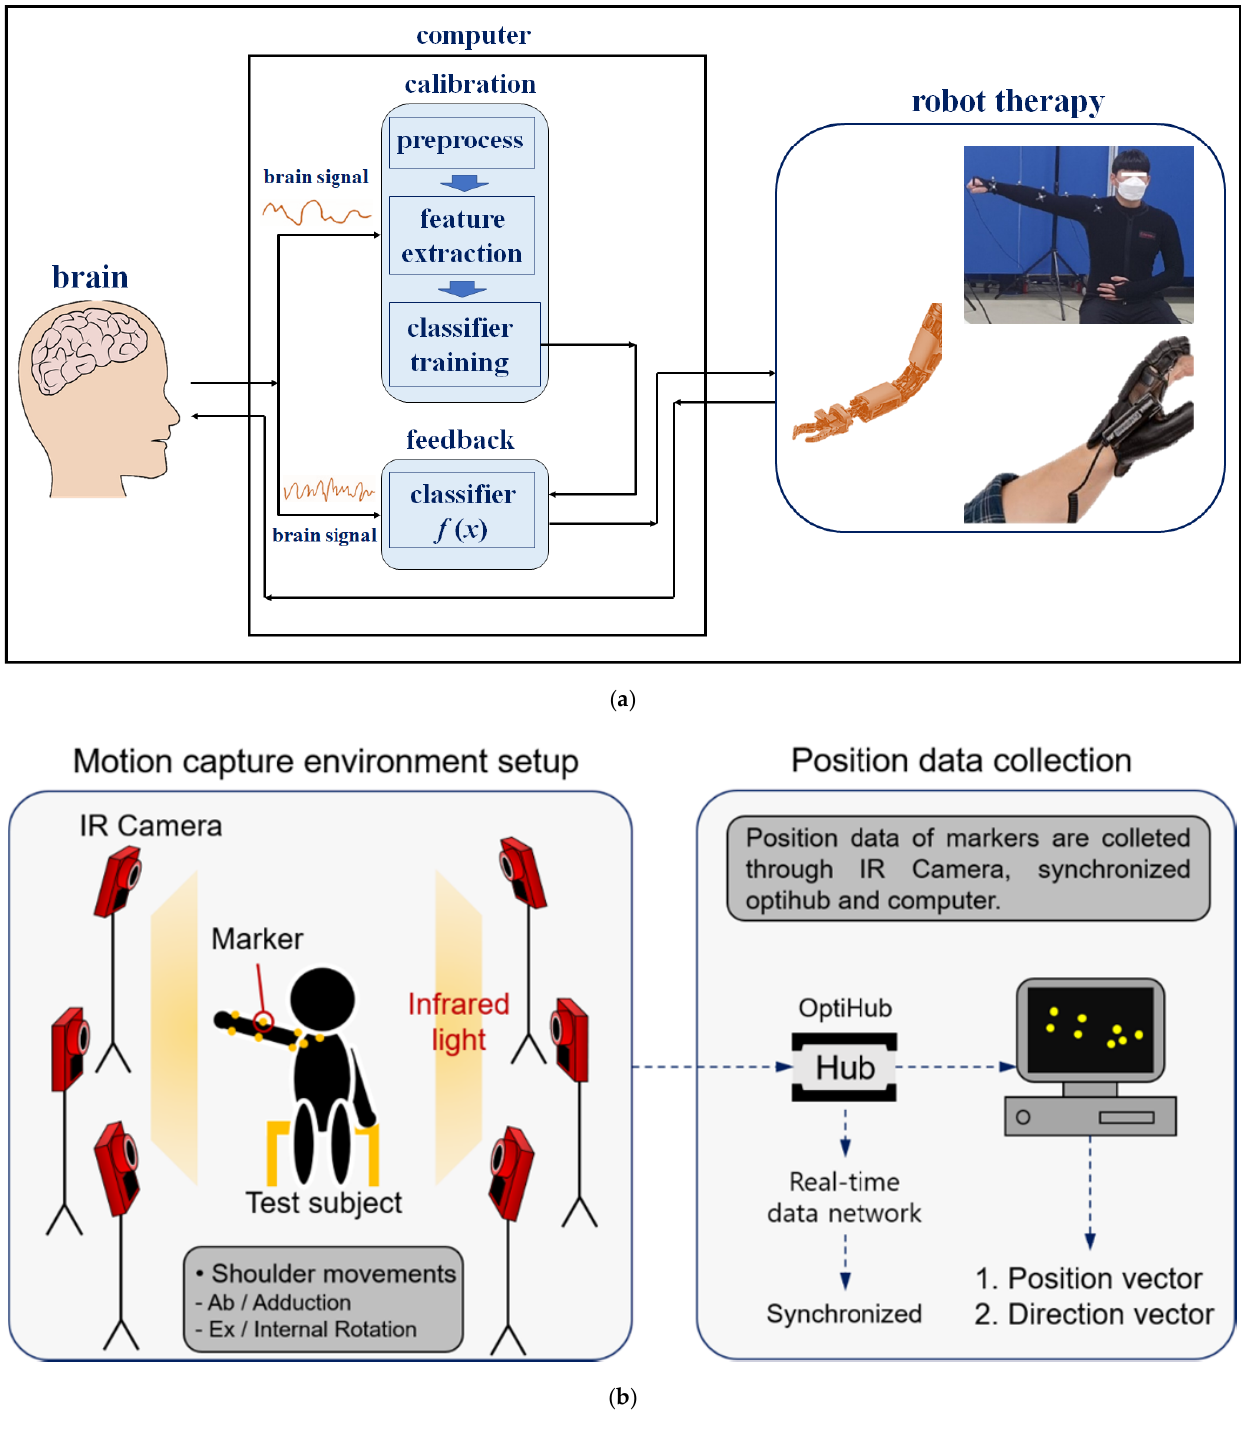
Figure 1. Configuration of a motion capture system for standardized rehabilitation exercise therapy.